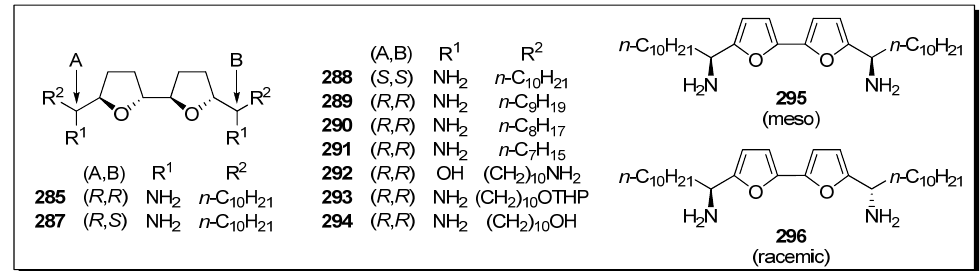
Figure 3. Diamino-bis-THF analogues by Sasaki’s group.